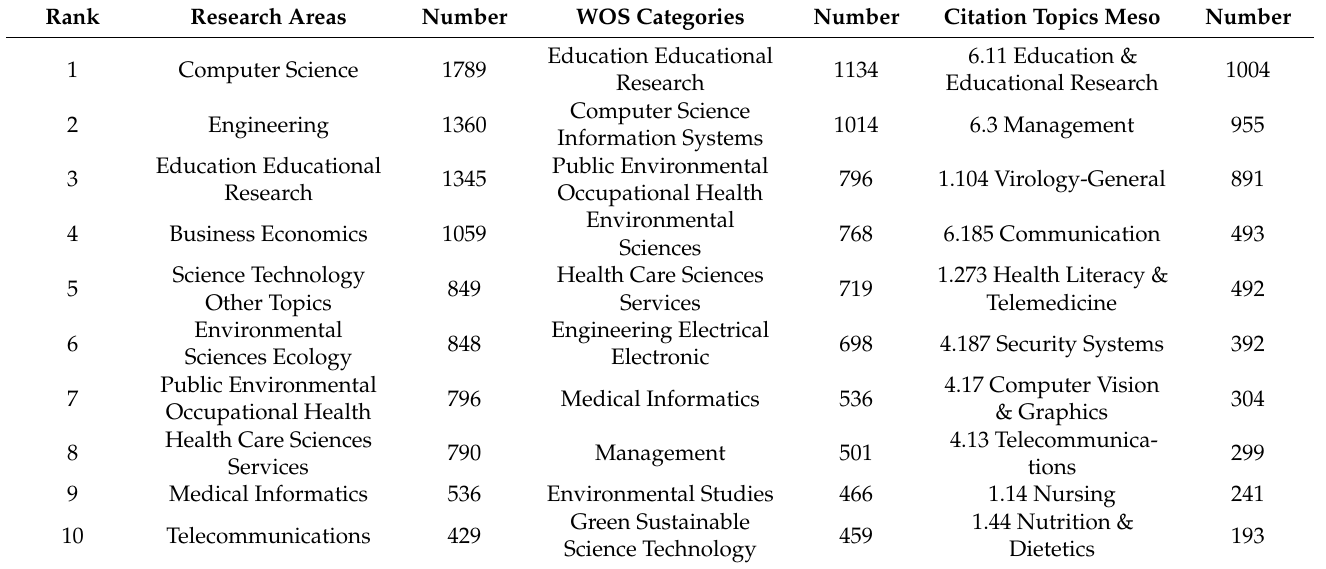
Table 2. Top 10 classifications and the corresponding article